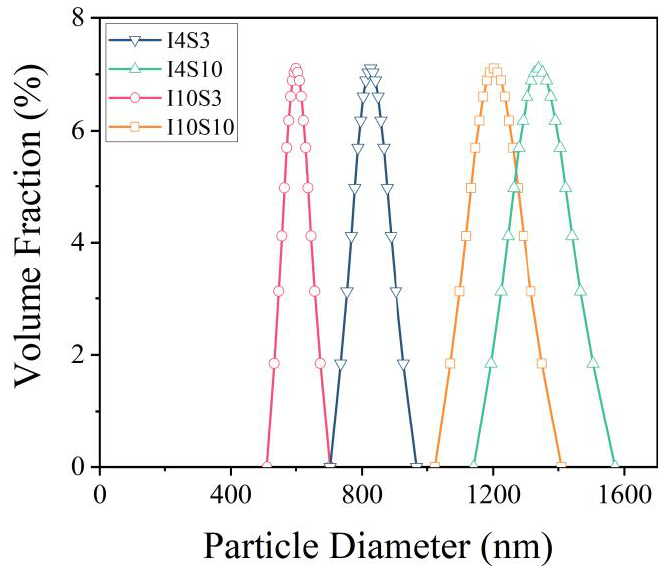
Figure 10. The particle size distribution of suspensions recycled from NaCl electrolyte.